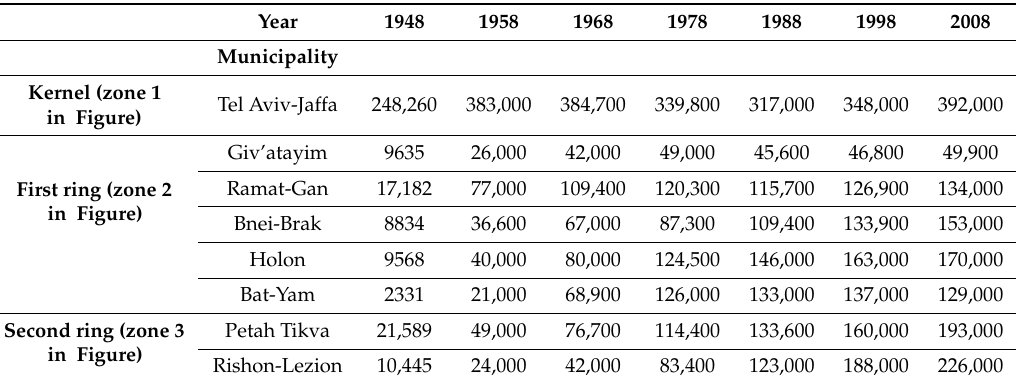
Table 1. Population of the municipalities of the Greater Tel Aviv area (“Gush-Dan”) during 1948–2008 from annual statistics of Israel (central bureau of statistics) for the years of 1948–2008. Other “second ring” municipalities (not mentioned in the table) that become significant since 1980 are: Efal, Kiryat-Ono, Or-Yehuda, and Yehud-Monosson (Figure 2). Population densities in 2008 vary from 1770 p/km 2 in Tel-Aviv municipality to 15,000 p/km 2 in Bat-Yam and 21,000 p/km 2 in Bnei-Brak. The last two, i.e., Bat-Yam and Bnei-Brak, are the densest in Israel.